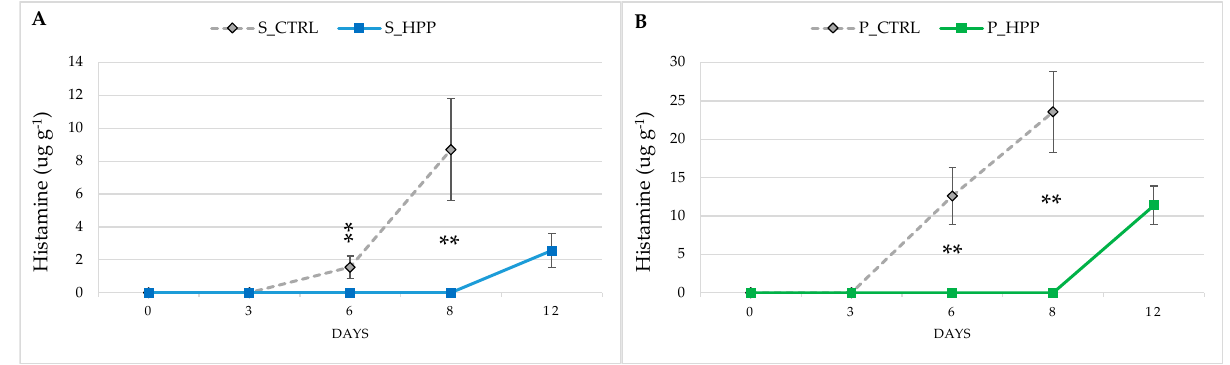
Figure 5. Trend of histamine on salmon (S_CTRL and S_HPP; ( A )) and plaice (P_CTRL and P_HPP; ( B )) fillets during shelf-life. The bar graphs show mean ( n = 3) ± standard deviation. Significant effect of groups is highlighted by asterisks: ** p < 0.01. Table 3. Sensory changes of salmon (S_CTRL and S_HPP) and plaice (P_CTRL and P_HPP) fillets at different storage days (mean ± standard deviation).